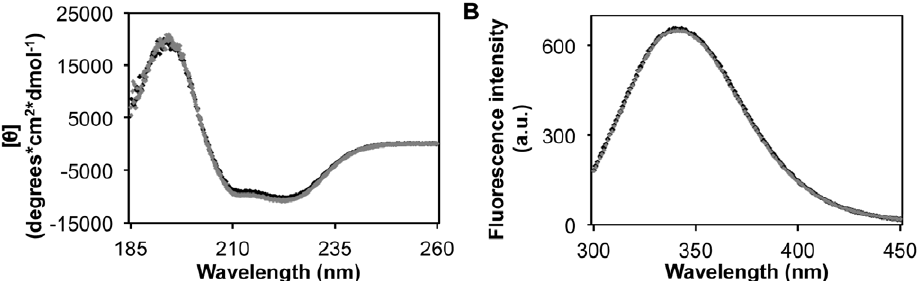
Figure 3. Phosphorylation hardly affects the structure of SERK1-KD. ( A ) Far-UV CD spectra of native SERK1-KD (black) and phosphorylated SERK1-KD (grey) at 15 u C. ( B ) Fluorescence emission spectra of 22 m M native SERK1-KD (black) and of 25 m M of phosphorylated SERK1-KD (gray), both acquired at 20 u C. Overlay of both spectra is obtained upon correcting for protein concentration difference.